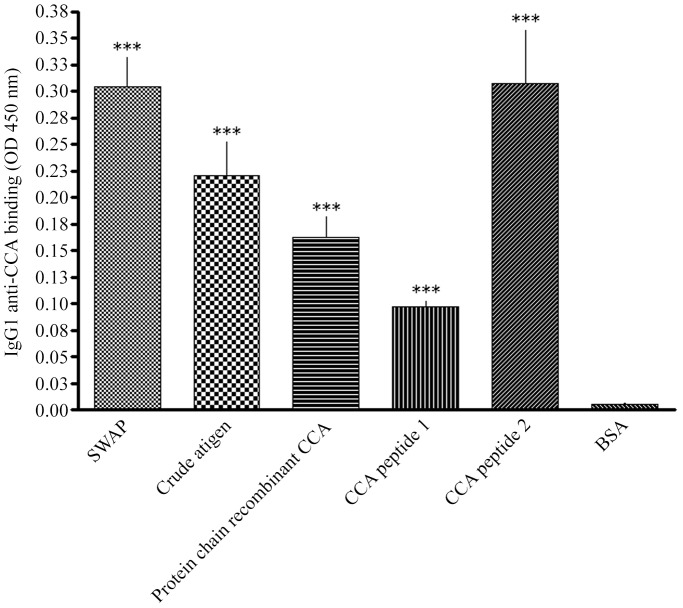
Binding of CCA-specific monoclonal IgG1 antibody to the four CCA antigens.Antigens represented by bars are: SWAP – soluble worm antigen preparation, as the positive control; “crude antigen”; protein chain of recombinant CCA; CCA peptides 1 (BCPred Score = 1) and 2 (BCPred Score = 0.926). Each OD value is representative for the mean of four absorbance values. Statistical differences for comparisons done to BSA are represented by *** (p<0.05) using Student's t test. Artwork created by Prism 5.0 software.